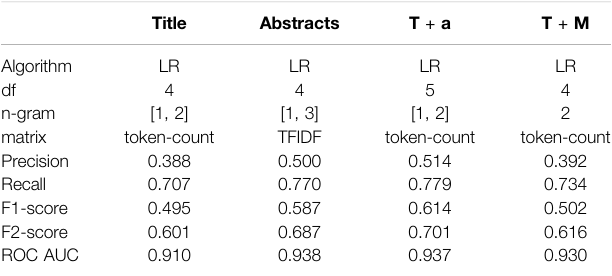
TABLE 4 | Algorithm and parameters used to get the highest F2 for each set of